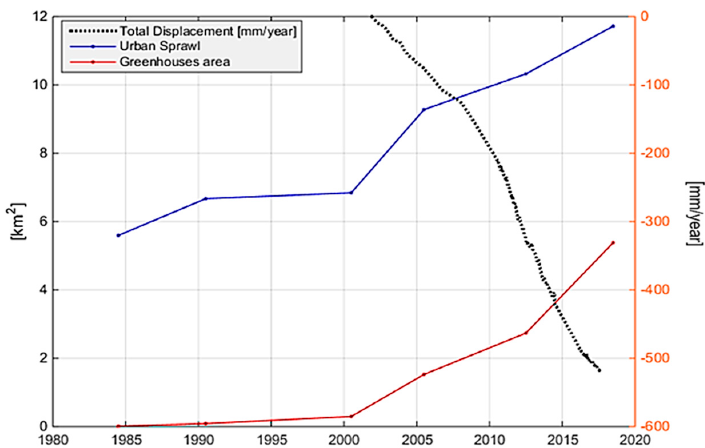
Figure 14. Trend of the urban sprawl in the municipality of Zapotlàn El Grande (blue dotted line) and of the growth of the greenhouse structures in square kilometers (red dotted line) compared with the deformation retrieved from the complete series of SAR data in the 2003–2018 period at site C (located in the northwestern part of CG, the one characterized by the highest deformation rates).